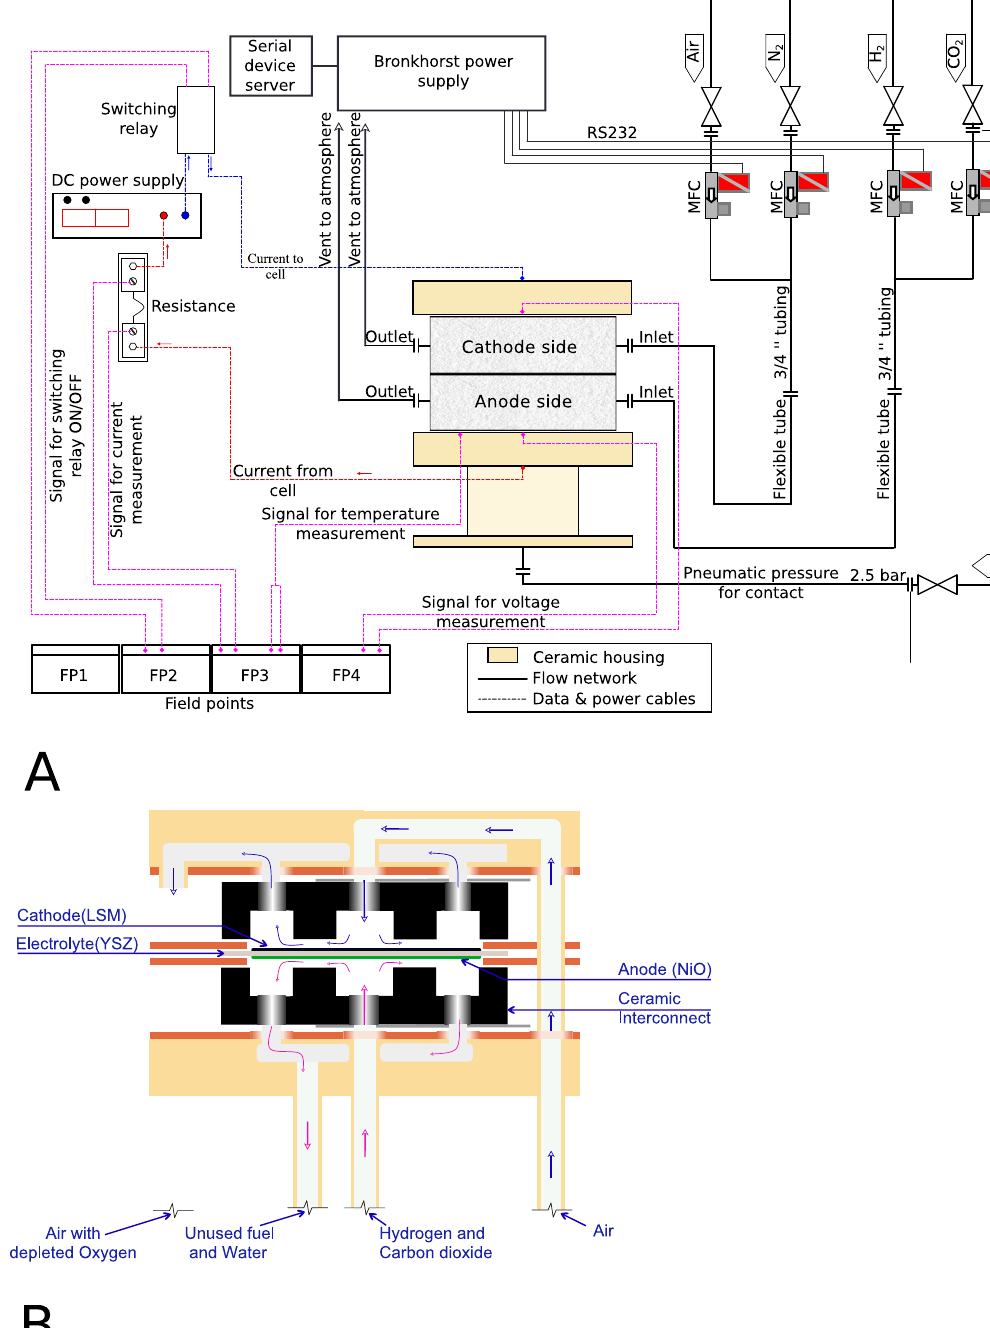
Figure 1. Piping and instrumentation diagram for the experimental set-up. (A) shows the whole setup, (B) a detail of the configuration around the cell